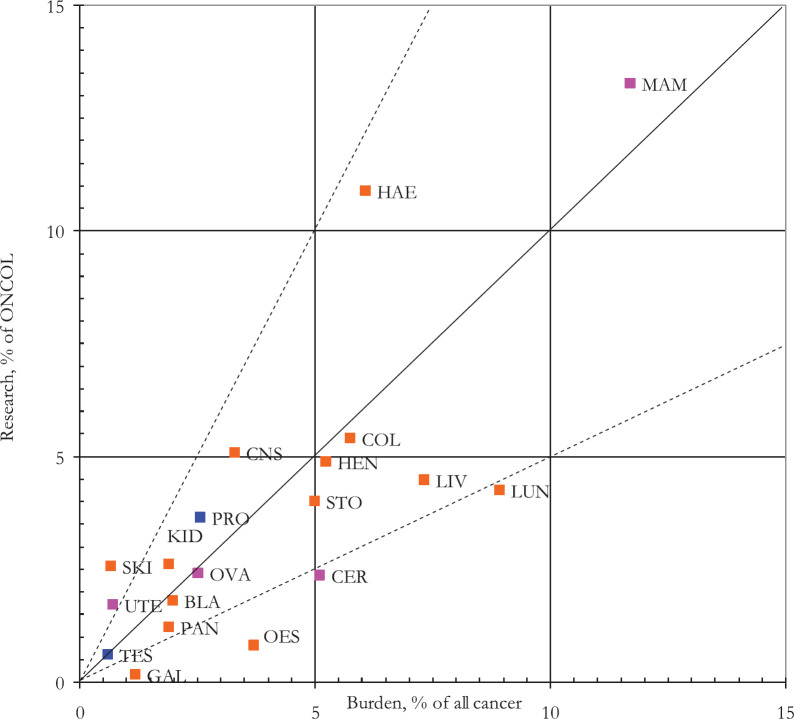
Percentages of all OIC cancer research papers, 2008–17, on individual cancer sites (integer counts) plotted against their collective burden (in DALYs; WHO data for 2010). (Blue spots: male cancers; pink spots: female cancers.) BLA=Bladder; CER=Cervix; CNS=Central nervous system; COL=Colon and rectum; GAL = gall bladder; HAE = Haematology; HEN=Head and Neck; KID = Kidney; LIV = Liver; LUN = Lung; MAM = Breast; OES = Oesophagus; OVA = Ovary; PAN = Pancreas; PRO = Prostate; SKI = Skin (incl. Melanoma); STO = Stomach; TES = Testicles; UTE = Uterus.